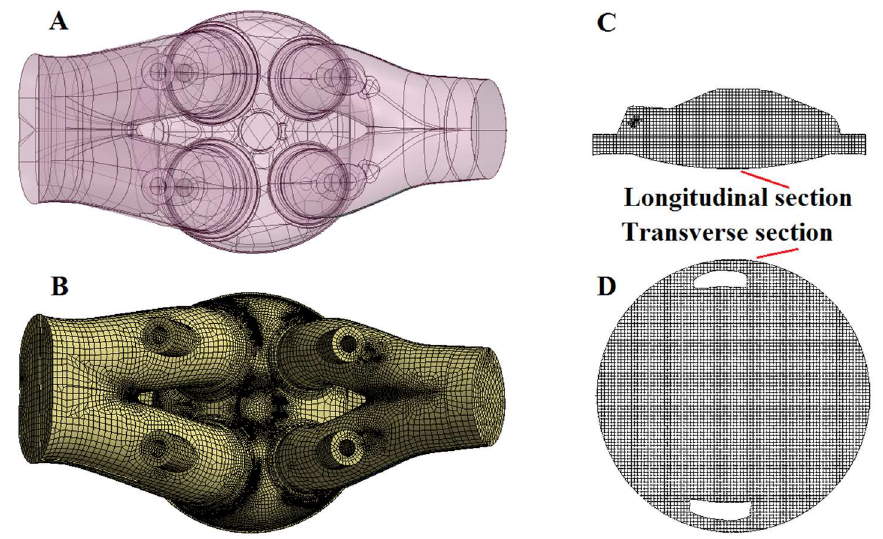
Figure 1. Structure body and mesh generation for the engine model: ( A ) STL model; ( B ) meshed model; ( C ) longitudinal section; ( D ) transverse section.